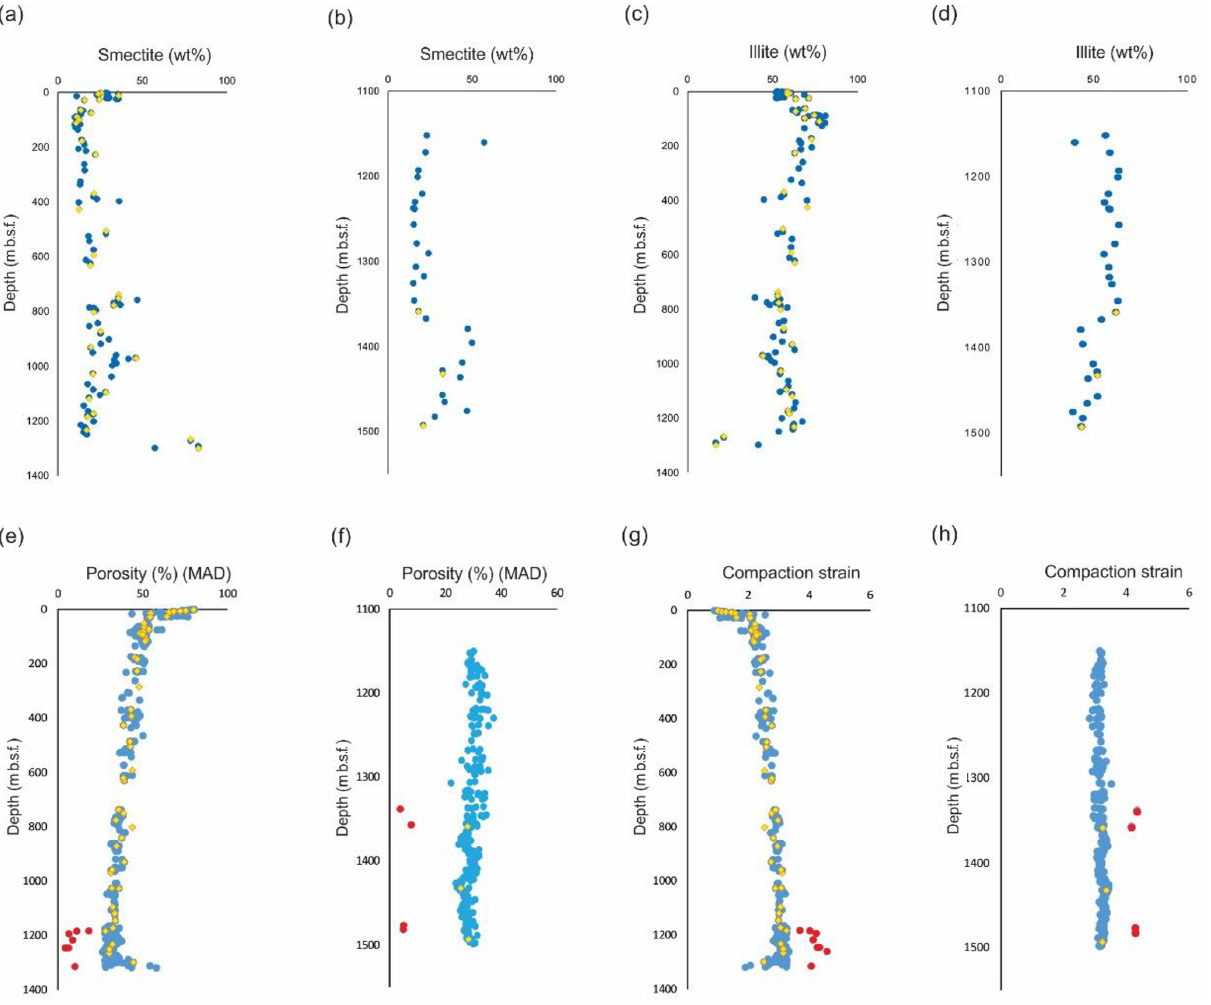
Figure 2. Depth profiles of smectite content (wt%; clay fraction) for Sites U1480 (a) and U1481 (b) (blue symbol). Depth profiles of illite content (wt%; clay fraction) for Sites U1480 (a) and U1481 (b) (blue symbol). Yellow symbols indicate samples analyzed by SEM imaging. (e–f) Shipboard MAD (moisture and density) porosity profiles for mudstone samples recovered from Sites U1480 and U1481 (blue symbol). (g–h) Calculated compaction strain profiles for Sites U1480 and U1481 (blue symbols). Red-colored points are cemented (concretion) samples. Clay mineralogy data are plotted from Rosenberger et al. (2020), and MAD data are extracted from McNeill et al.